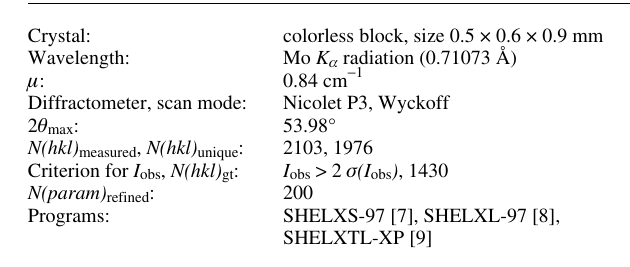
Table 1. Data collection and